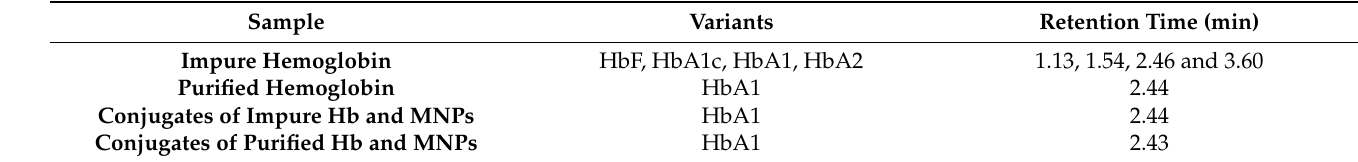
Table 2. Identification of hemoglobin variants through cation exchange